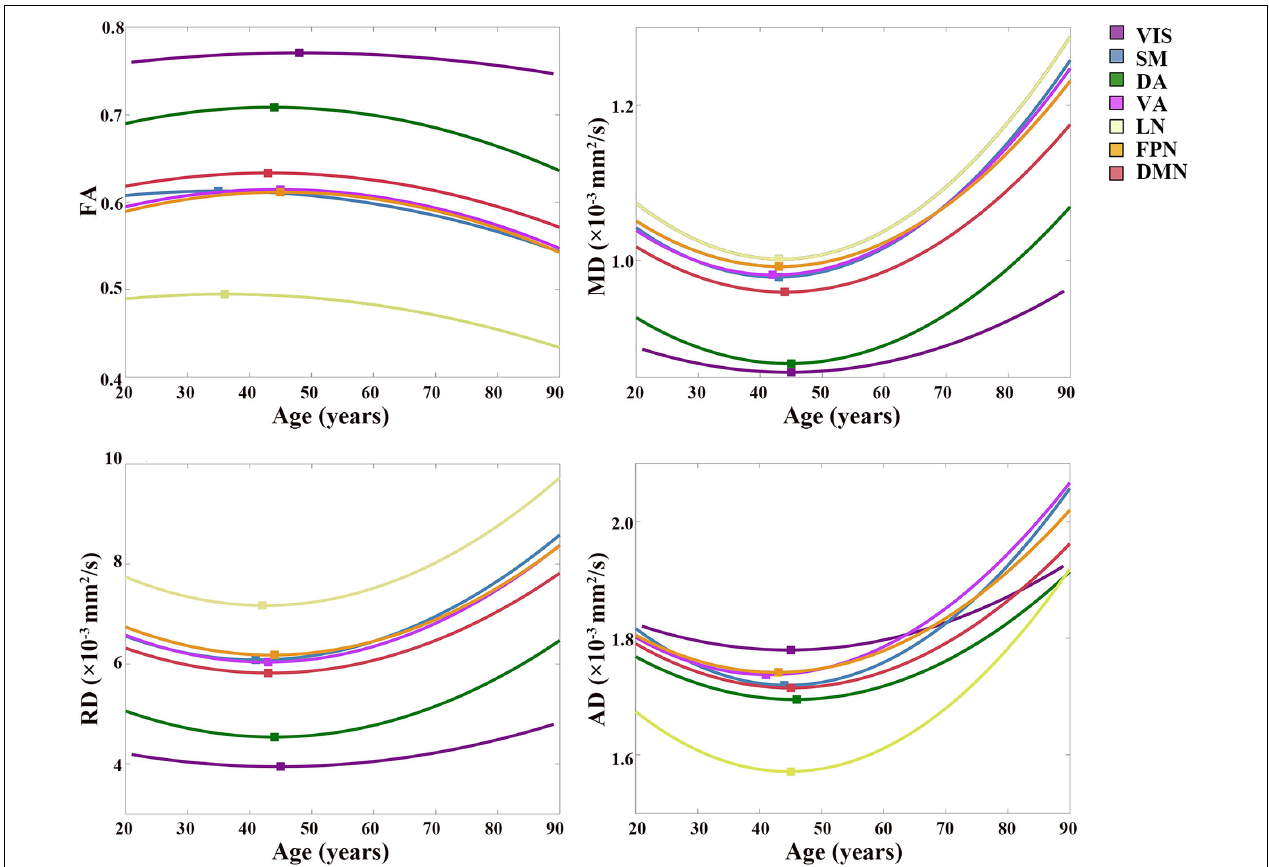
FIGURE 4 | Best-fitting curves for regressed diffusion indices vs. age. Ages of peak FA values and minimum MD, RD and AD values from the quadratic fits are labeled by colored squares for all the subregions. Fit curves of all diffusion indices in the subregion to VIS are flat, which indicated that slight changes occurred in the microstructure of the CC fibers interconnecting the VIS during the aging process. On the contrary, fit curves of the rest subregions exhibited a U shape of the fit curves of MD, RD, and AD, and an inverted U shape of the fit curve of FA. The scatter plots of DTI indices vs. age are shown in Supplementary Figure 3 . VIS, CC subregion connecting to the visual network; SM, CC subregion connecting to the somatomotor network; DA, CC subregion connecting to the dorsal attention network; VA, CC subregion connecting to the ventral attention network; LN, CC subregion connecting to the limbic network; FPN, CC subregion connecting to the frontoparietal network; DMN, CC subregion connecting to the default mode network; FA, fractional anisotropy; MD, mean diffusivity; RD, radial diffusivity; AD, axial